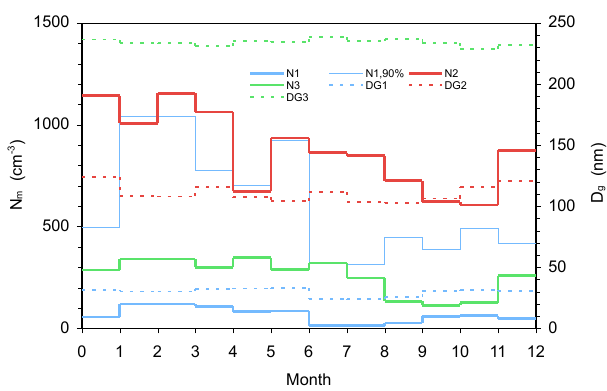
Fig. 7. Monthly medians of the total particle numbers N m ( N 1 – N 3 , cm − 3 , full lines) and geometric mean diameters D g ( D g1 – D g3 ,nm, dashed lines) of three lognormal distributions fitted to the particle number size distributions measured at ZOTTO. The 90th percentile of N 1 is drawn as thin full